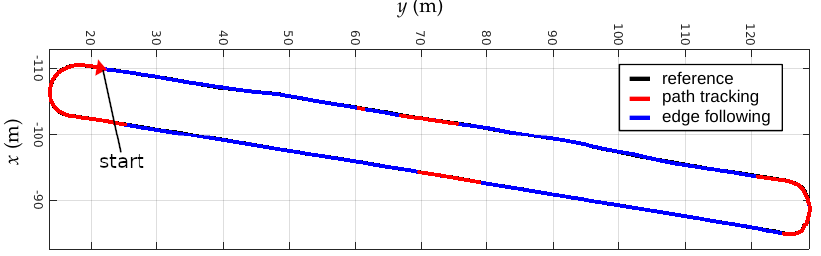
Figure 12. Absolute position ( x , y ) of the robot. In red, the robot is in path tracking mode; in blue it is in furrow pursuing mode. The black trajectory corresponds to reference trajectory to follow.